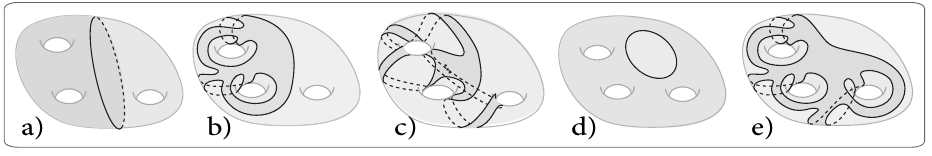
Figure 12. Examples of irreducible apparent contours of fold maps with zero degree over